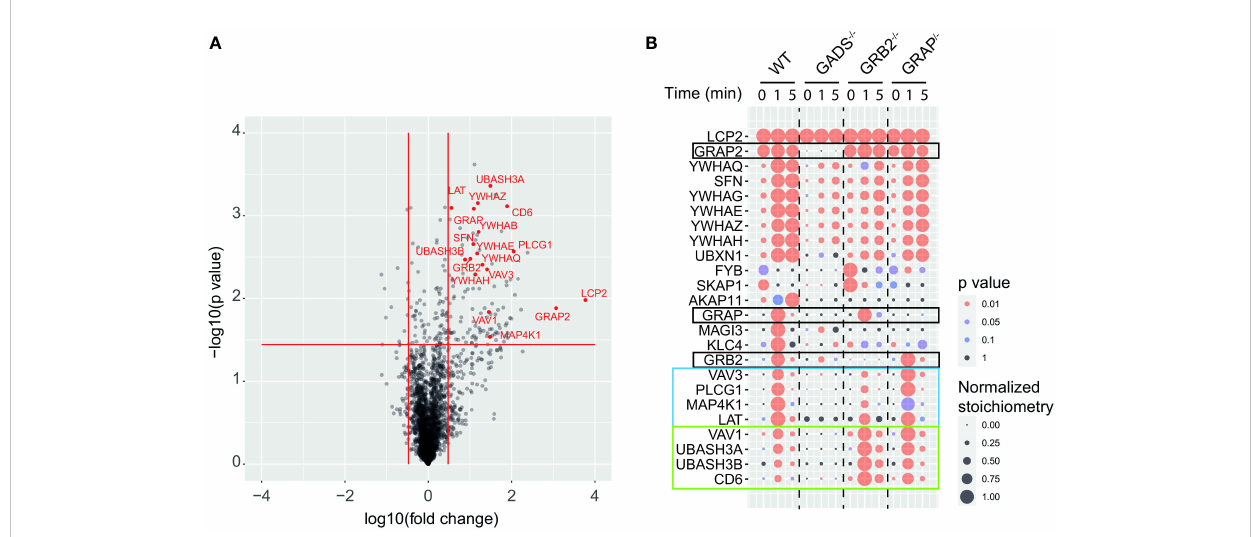
FIGURE 2 GRB2-family adaptors dependent and independent SLP76 protein interactions. (A) Volcano plot showing protein enrichment of af fi nity puri fi ed SLP76 OST from WT Jurkat cells compared to parental Jurkat cells expressing similar levels of untagged SLP76 proteins at 60 s after CD3 stimulation. Enriched preys are identi fi ed by a fold change > 3 and pvalue <0.01. Canonical SLP76 interactors are highlighted in red. (B) Dot plot showing the interaction stoichiometry of SLP76 with the 23 high-con fi dence preys for which the interaction stoichiometry is regulated by the inactivation of one the GRB2-family adaptors (fold change > 2.5 and pvalue <0.05). The interaction stoichiometry has been row-normalized to its maximum value observed over stimulation conditions (see key for Normalized Stoichiometry). The pvalue key is related to protein enrichment of the analysis in (A) . GRB2-family adaptors are framed in black. The two distinct SLP76 modules are framed in blue and